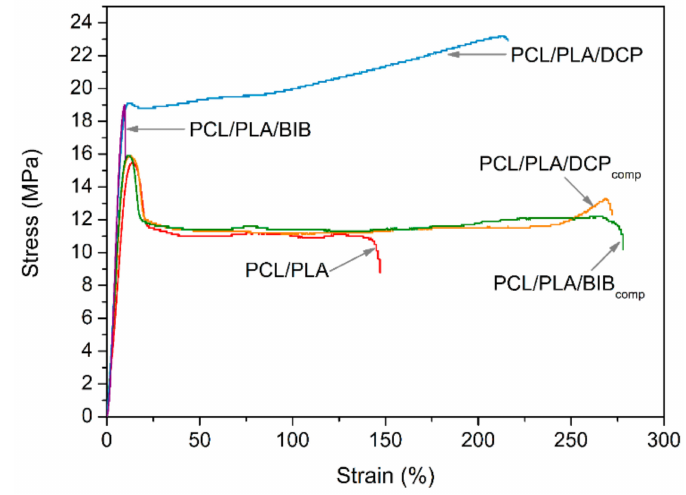
Figure 7. Representative stress-strain curves of studied PCL / PLA